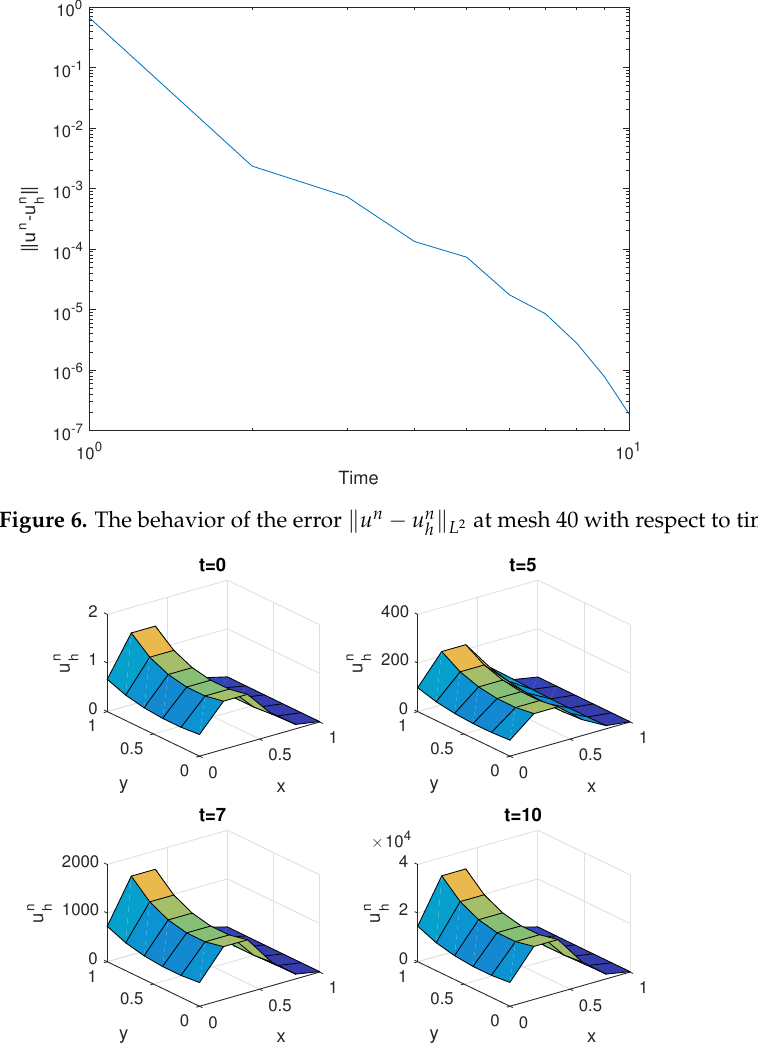
for the values 0 ≤ x ≤ 1 and 0 ≤ y ≤ 1 at time t = 0,5,7,10 for h